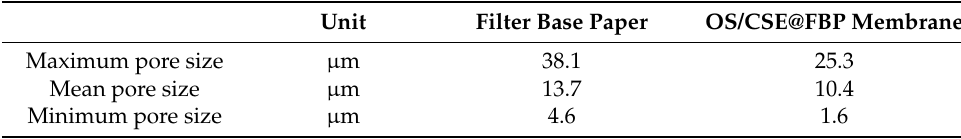
Table 1. Pore sizes of base paper and OS/CSE@FBP membrane.